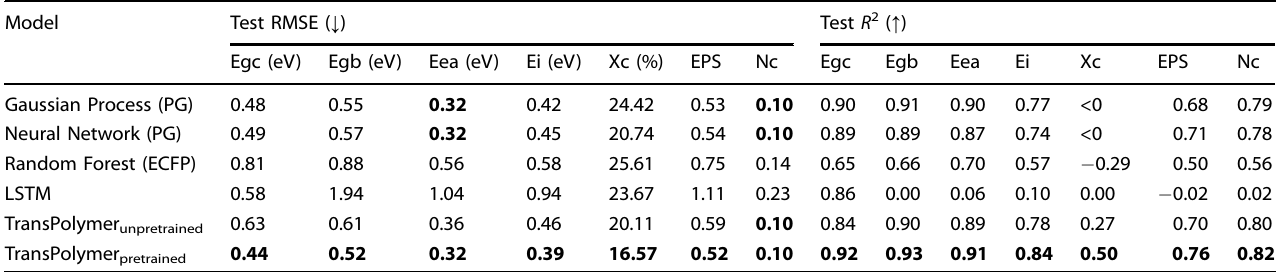
Table 4. Performance of TransPolymer and baseline models on datasets from literature by Kuenneth et al. 54 . Model